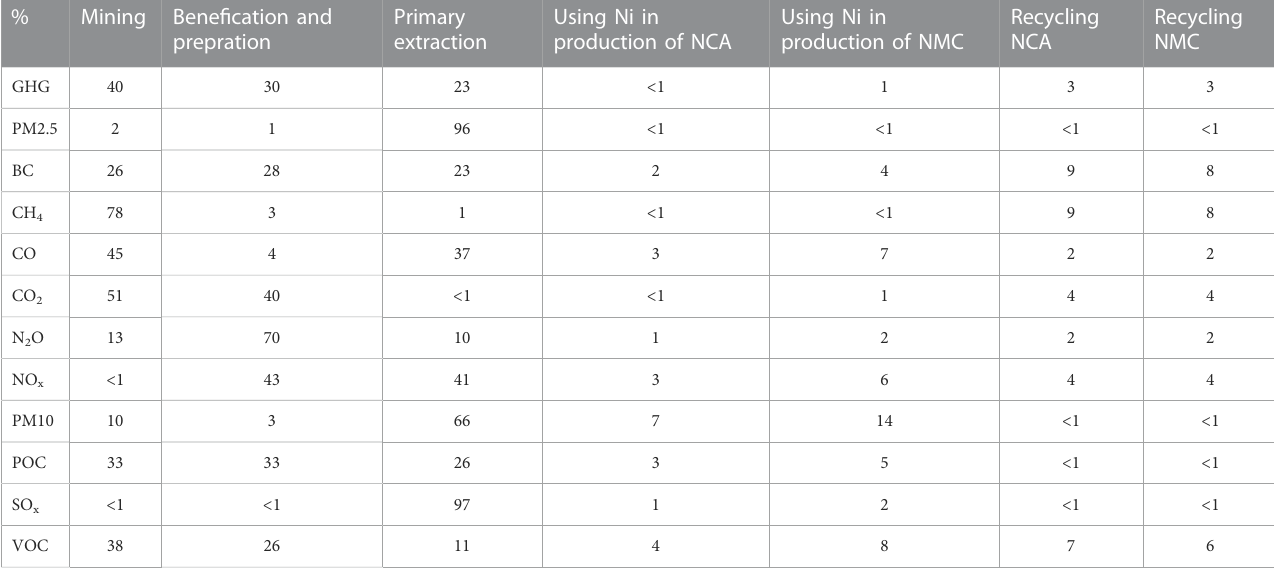
TABLE 3 Emissions from different stages of the nickel supply chain (in %) in the period 2010 –